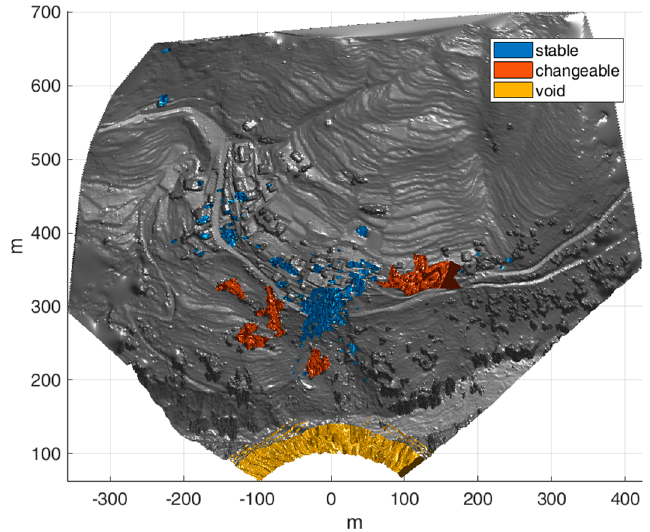
Figure 22. DA map divided in three classes and projected on the DSM.